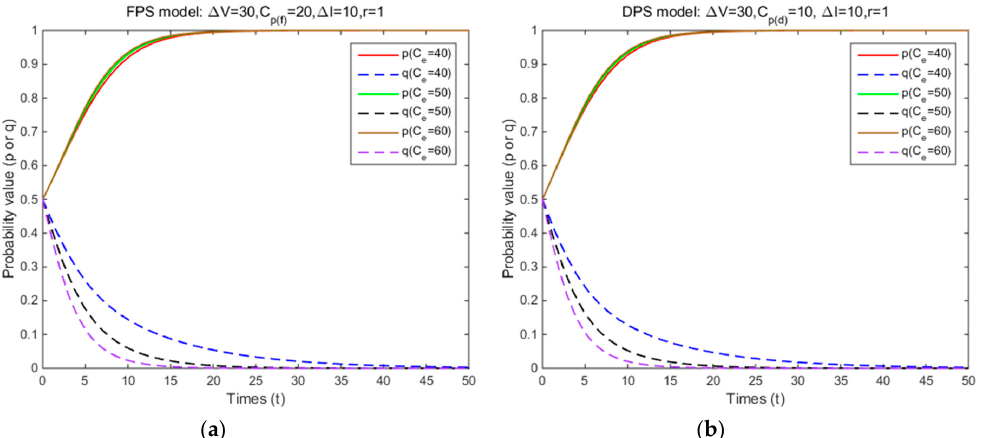
Figure A5. The effects of enforcement cost on strategy probabilities of cyclists and law enforcement under FPS ( a ) and DPS ( b ) (Situation 1).